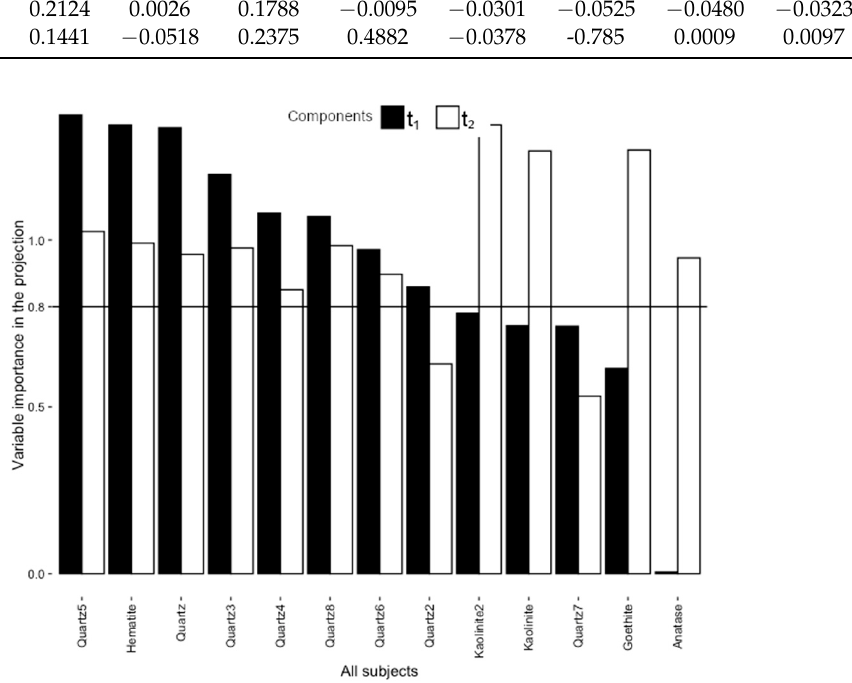
Figure 5. Graph of variable importance in the projection for components t 1 and t 2 . All variables lower than 0.8 importance were removed from the model.